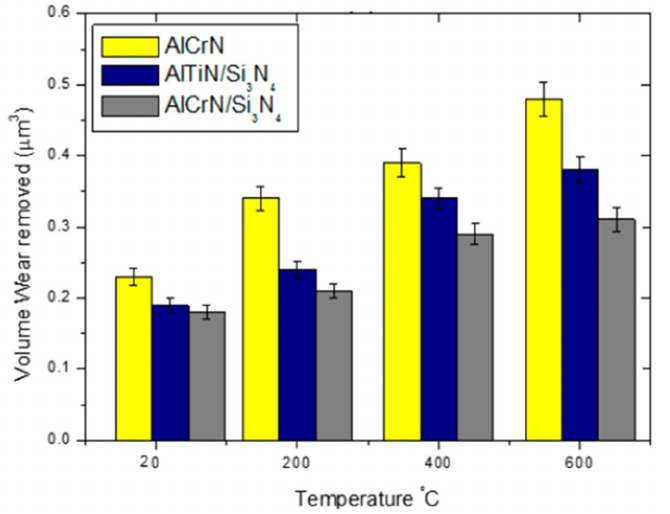
Figure 16. Volume wear for AlCrN, AlTiN/Si 3 N 4 and AlCrN/Si 3 N 4 coatings at various temperatures [206].